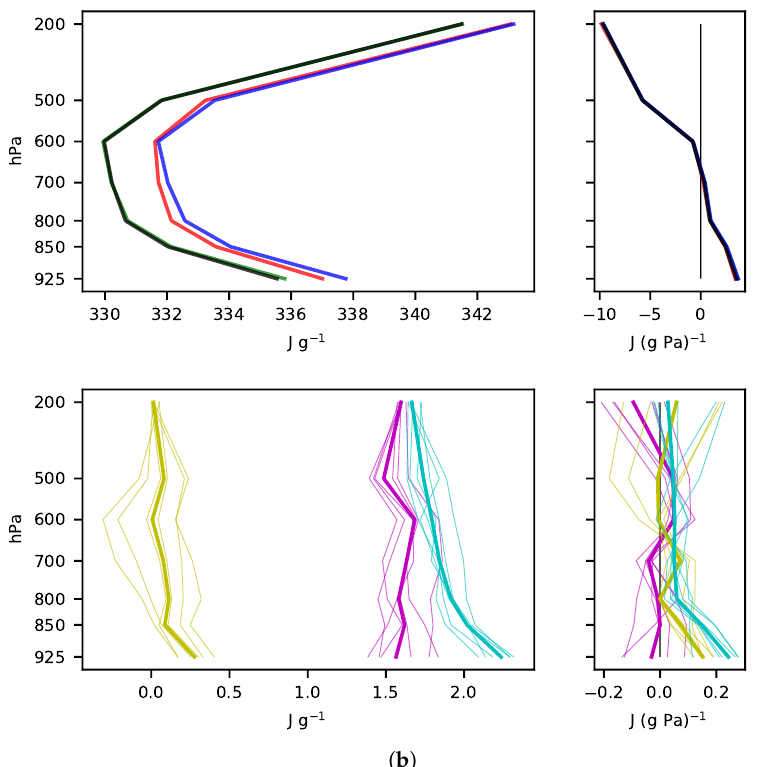
Figure 9. Guinea ( a ) and Sahel ( b ) regional mean JAS vertical profile of MSE ( left ) and MSS ( right ) for the control and sensitivity experiments ( top ) and anomalies ( bottom ). Thick lines are study period median values and thin lines are individual